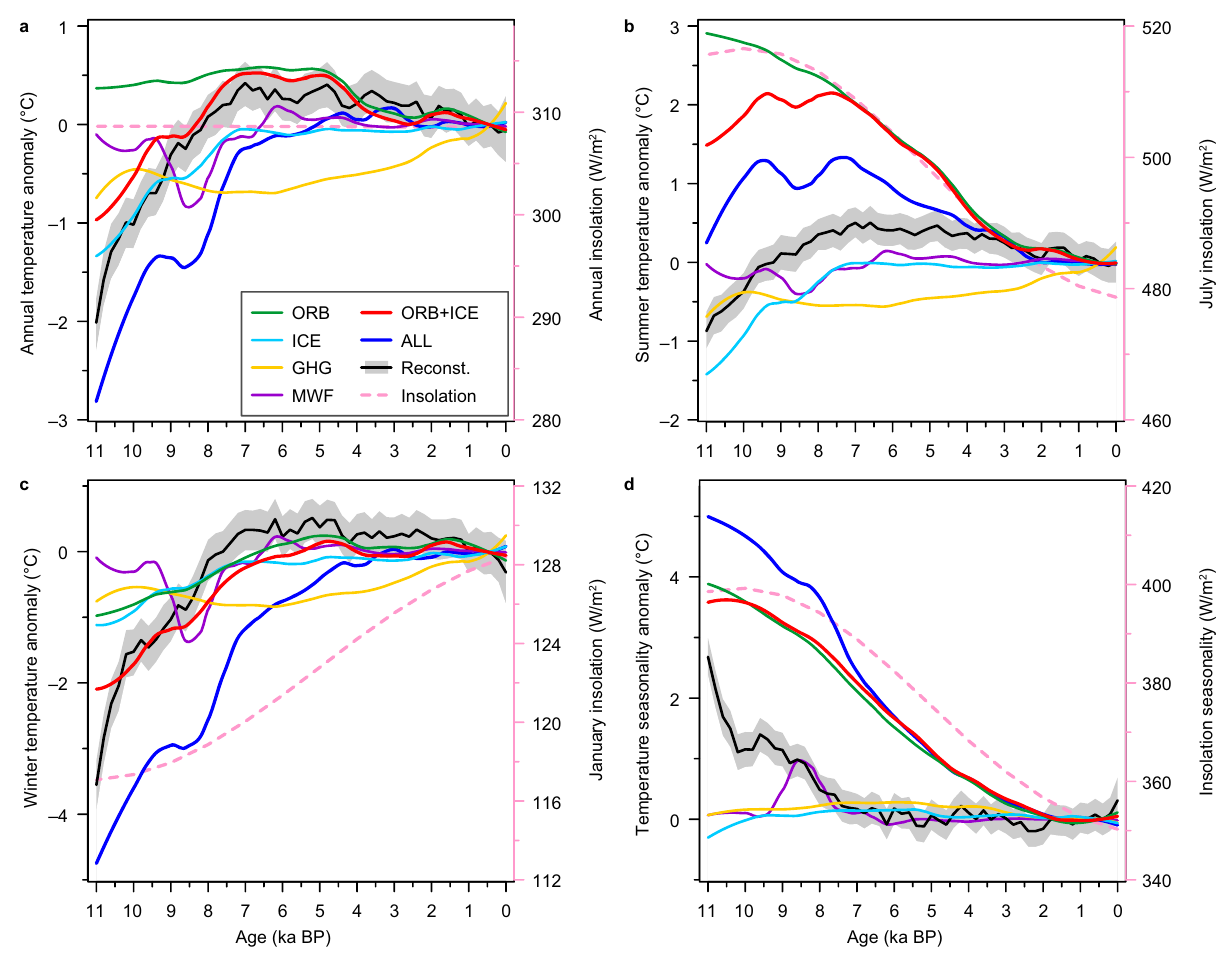
Fig.4|AnnualandseasonaltemperaturetrendsovertheNorthernHemisphere landmass under full and individual forcings from the TraCE-21ka simulation. Changes of ( a ) annual, ( b ) summer and ( c ) winter temperatures, and of ( d ) tem- peratureseasonalityduringtheHolocene.Forcingsincludeorbitalvariations(ORB, green),icesheets(ICE,skyblue),atmosphericgreenhousegases(GHG,yellow),and